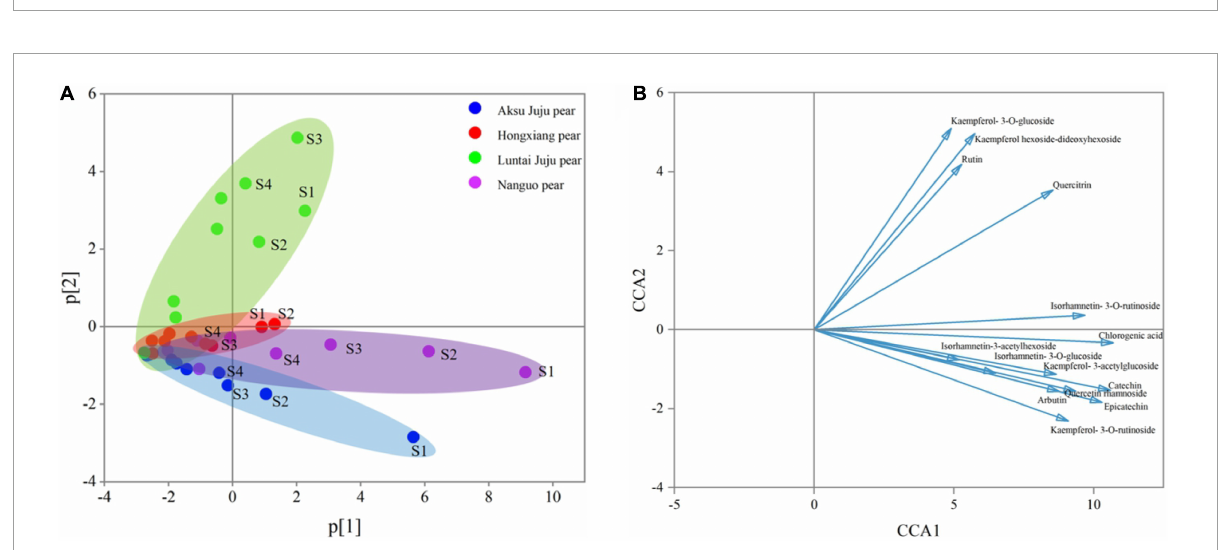
FIGURE4 PCA principal component analysis of phenolic compounds from four pear species. (A) PCA score plot and (B) PCA loading plot of all measured primary phenolic compounds profiles. S1, S2, S3, and S4 correspond to 5/25, 6/8, 6/22, and 7/7, respectively, same